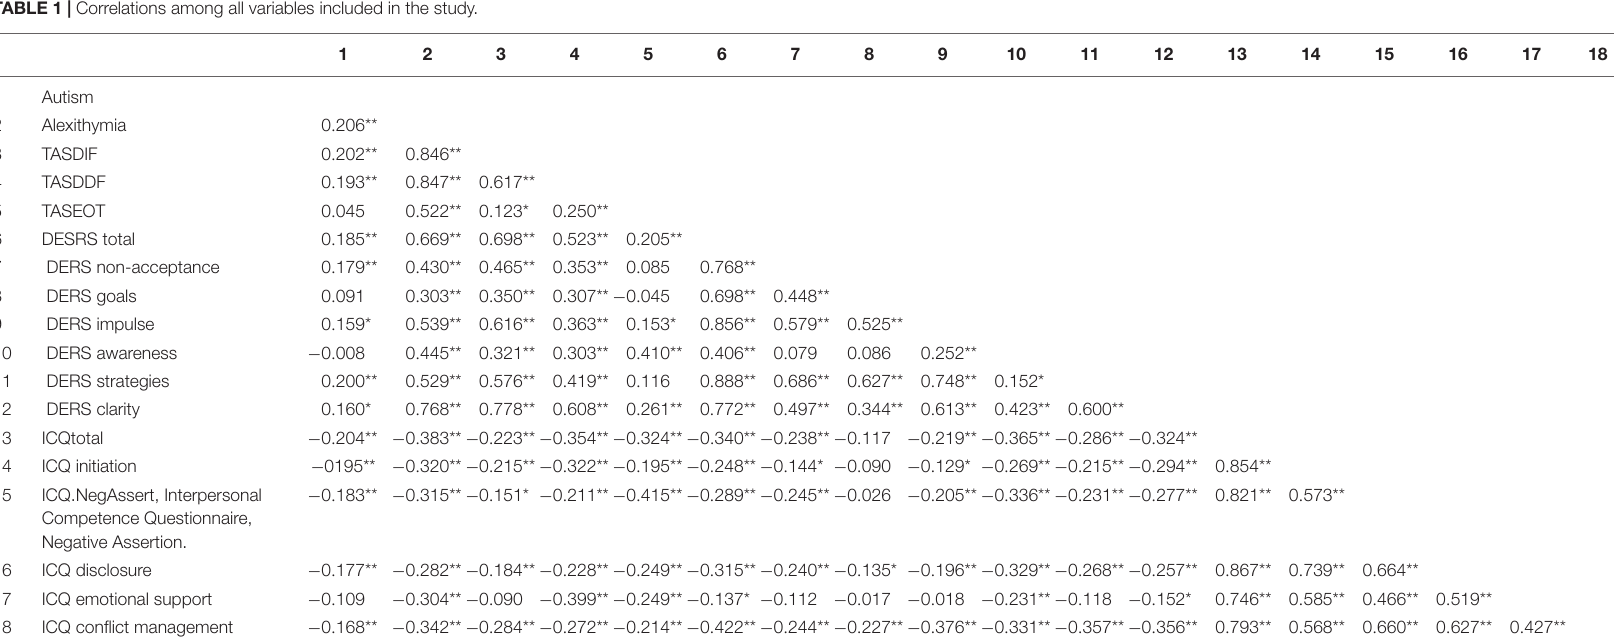
TABLE 1 | Correlations among all variables included in the